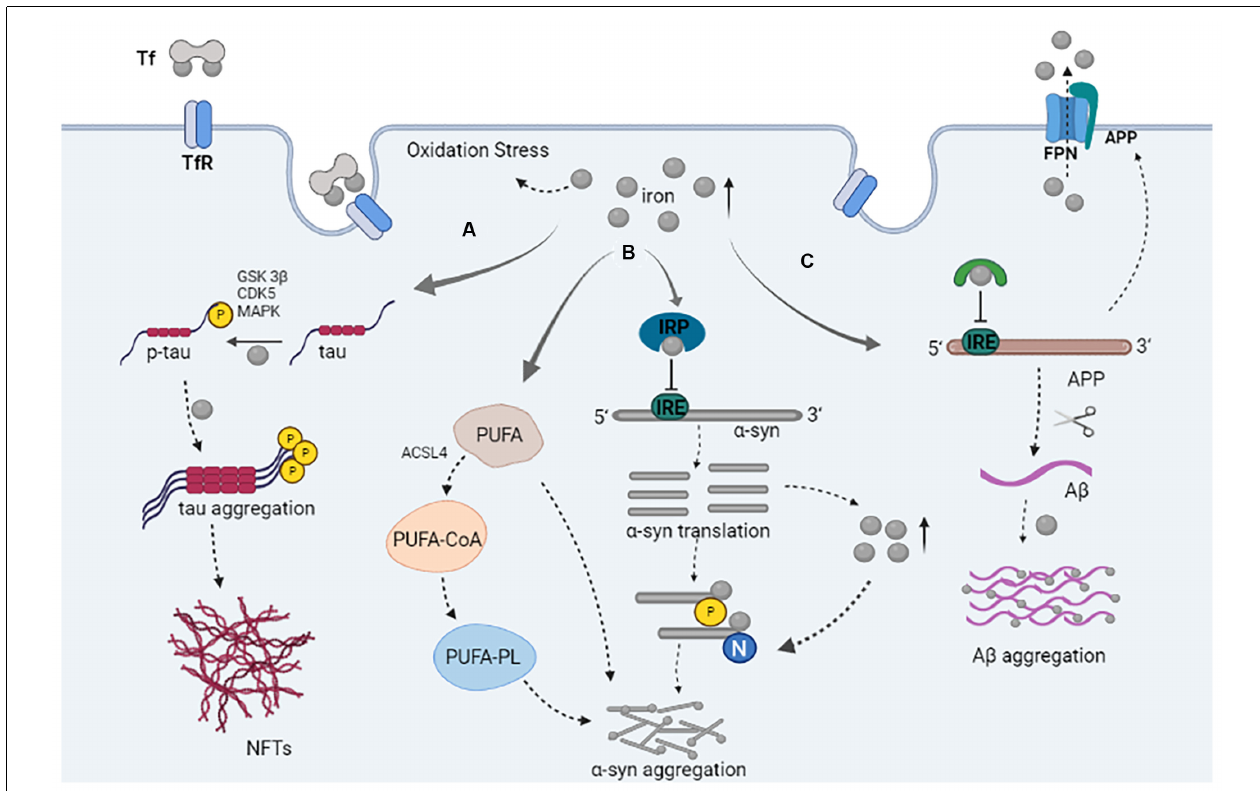
FIGURE 1 | The role of iron in the pathology of tau, α -syn, and A β . (A) Iron and tau kinase (GSK3 β , CDKs, MAPK) play a role in the phosphorylation of tau; iron promotes tau aggregation and NFTs formation. (B) The binding of IRP to iron inhibited its binding to IRE, resulting in increased expression of α -syn; α -syn can promote an increase in iron levels; iron participates in the post-translational modification of α -syn and promotes the aggregation of α -syn. Iron can promote the increase of PUFA; PUFA are conjugated to CoA by ACSL4 allowing PUFA-CoA to be incorporated into the phospholipids (PL); free or phospholipid-bound PUFAs promote the aggregation of α -syn. (C) The binding of IRP to iron inhibits its binding to IRE, which results in increased APP expression. The synergistic effect of APP and FPN causes iron outflow; A β produced from APP processing; iron promotes A β